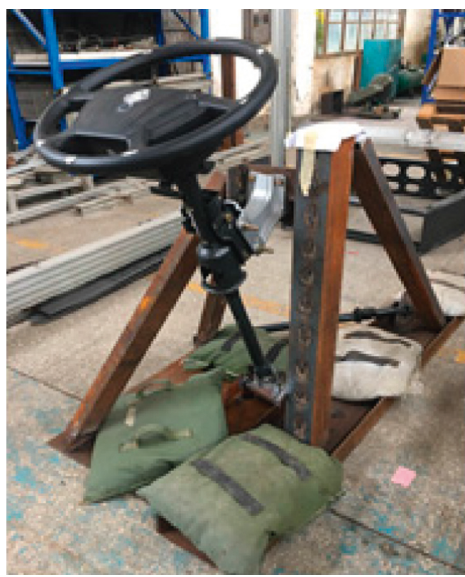
Figure 15: Extracted solid model of the steering system.